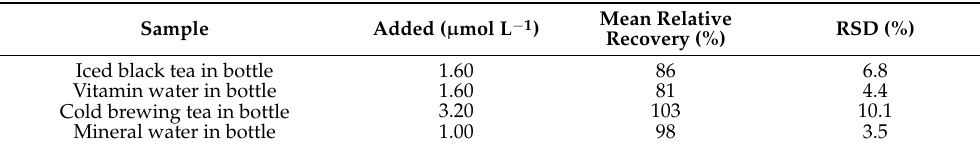
Table 2. Total concentrations and recovery of PAEs in spiked soft drink samples using five-component standard solutions containing equal concentrations of the components.